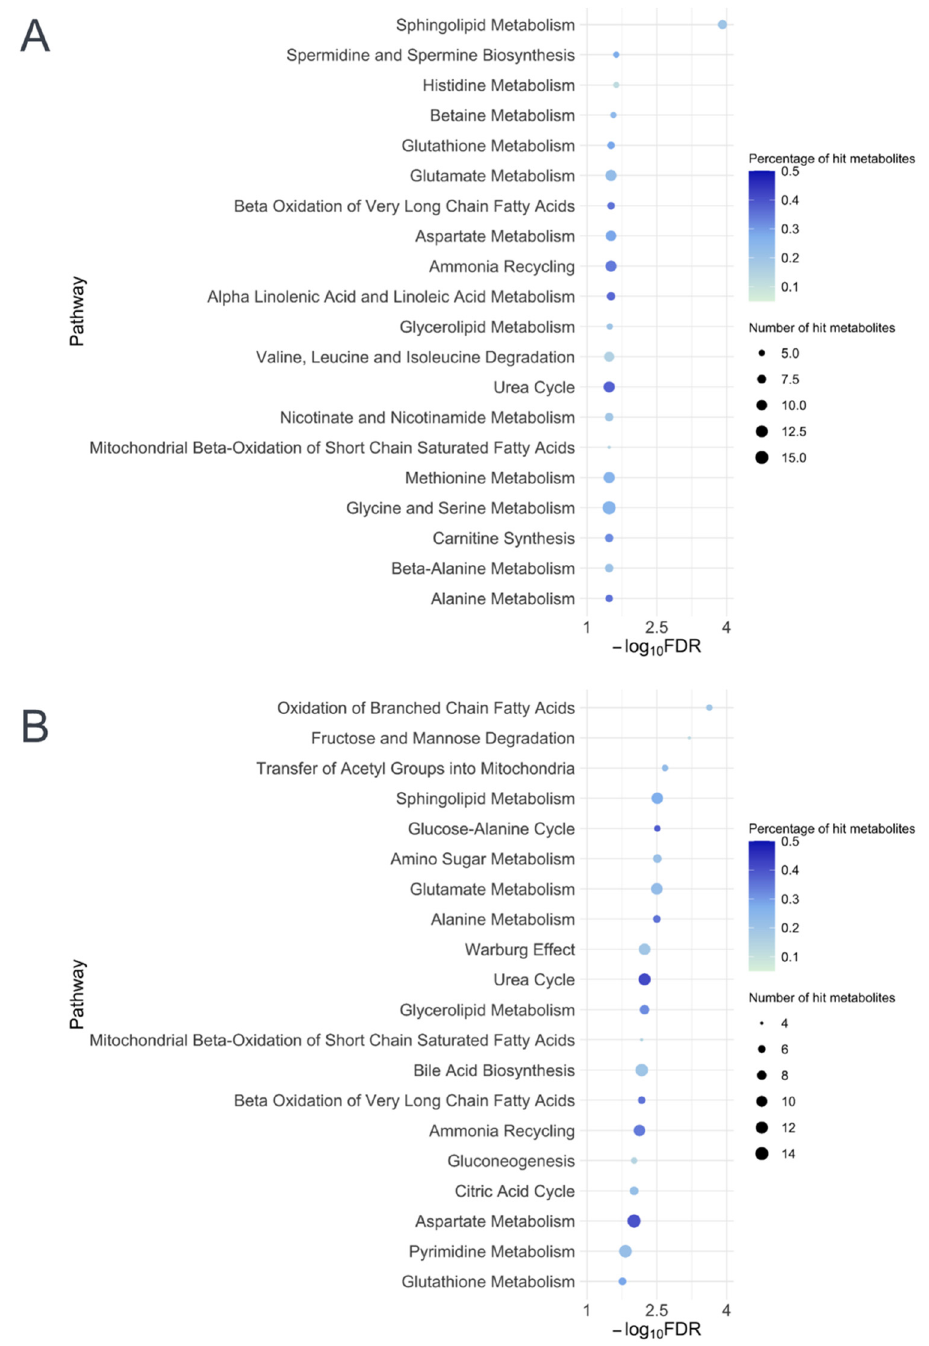
Figure 5. Pathway analysis of nasopharyngeal and serum metabolites differentially enriched among infants who underwent positive pressure ventilation. The shown metabolite pathways (based on the SMPDB) are the top 20 ( A ) nasopharyngeal and ( B ) serum pathways with the smallest FDRs that have the number of hits per pathway of >4 metabolites and the percentage of hits per total compound of >10%. The color of each dot represents the proportion of hit metabolites; the size of each dot represents the number of hit metabolites. The glutathione pathway was significantly differentially enriched by the positive pressure ventilation outcome in both nasopharyngeal and serum metabolome data (both FDR < 0.05). Abbreviations: FDR, false discovery rate; SMPDB, Small Molecule Pathway Database.